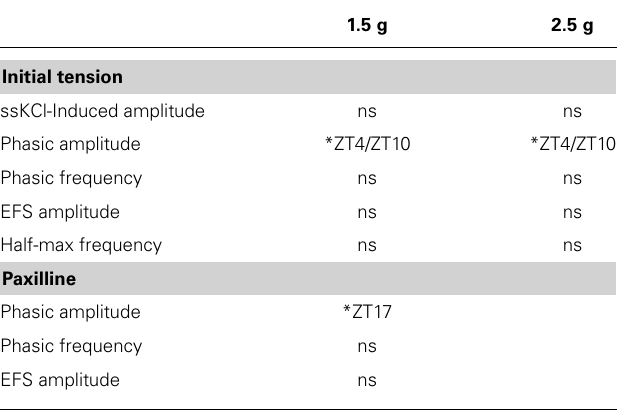
Table 1 | Effect of time of day on UBSM contractility at two initial tensions.